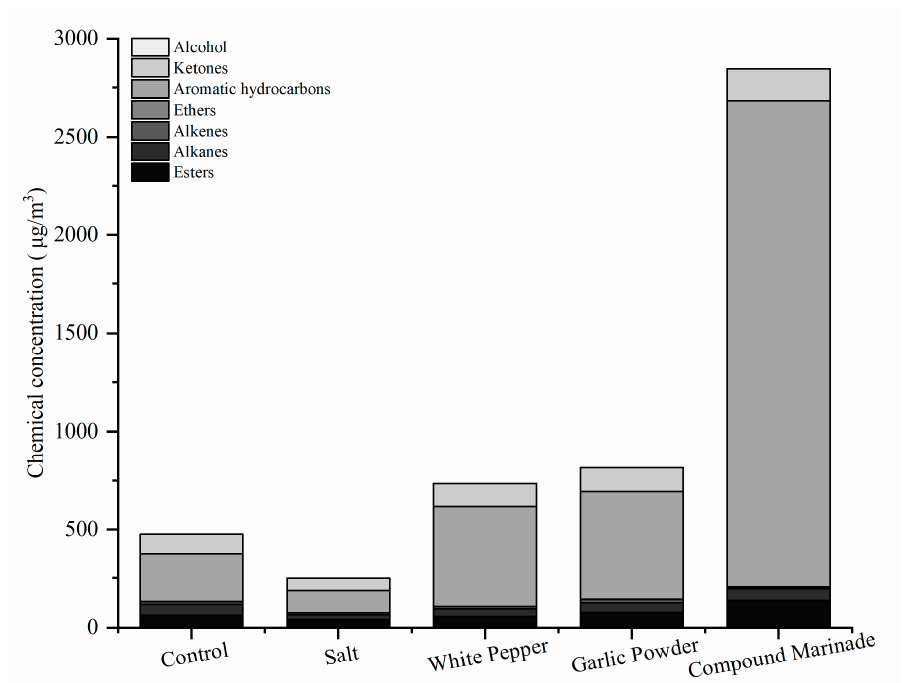
Figure 4. The speciation of VOCs detected in the cooking fumes during the meat grilling.